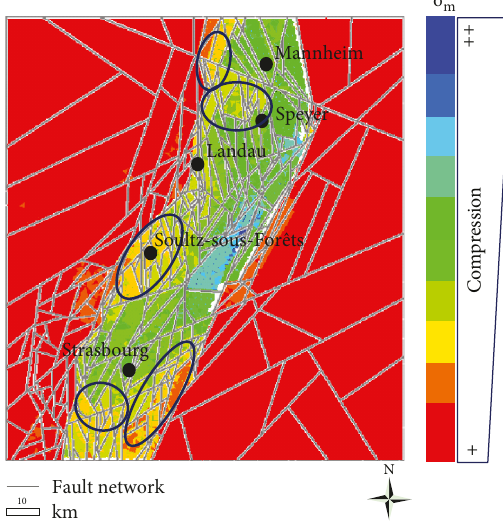
Figure 8: Mean stress distribution in the model and the delineated preferential target areas